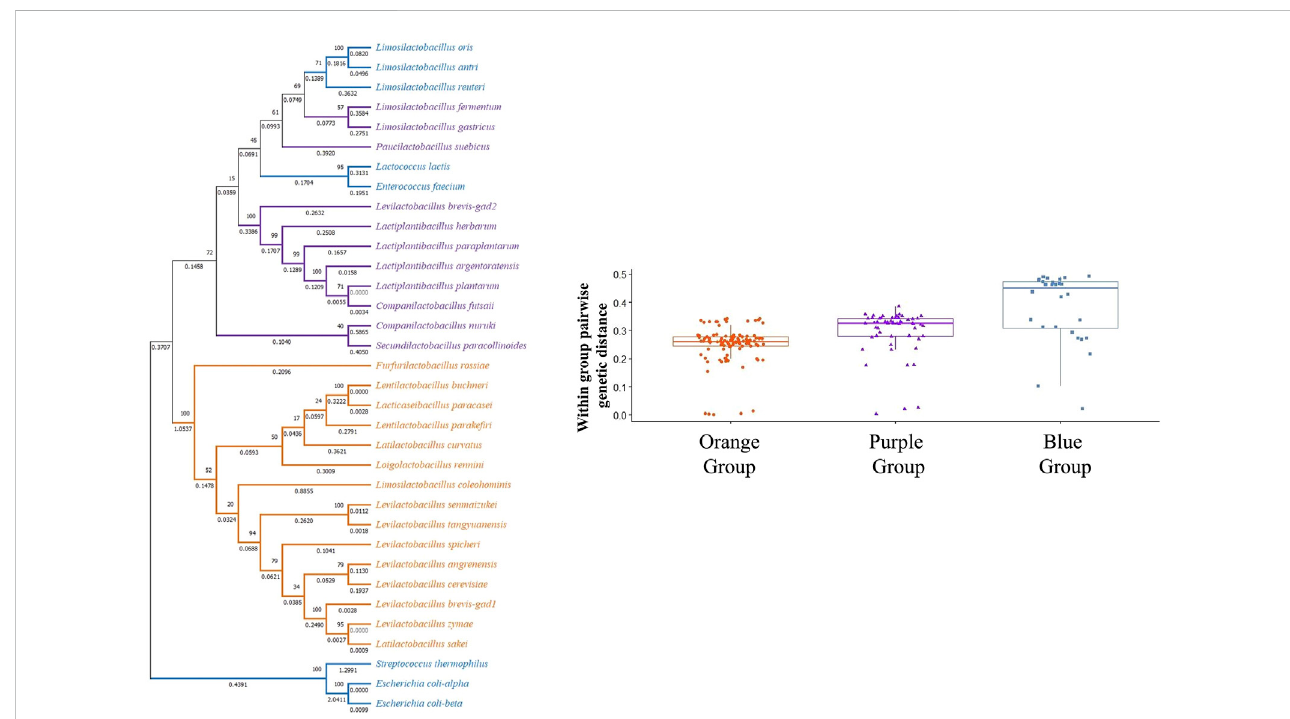
FIGURE 6 Phylogenetic tree based on gad gene sequences from 32 bacterial species. The tree was constructed with MEGA-X using the Maximum Likelihood method and General Time Reversible (GTR) model. One thousand replicates were used to generate the bootstrap consensus tree. A discrete Gamma (G) distribution was used for evolutionary rate variations across sites. Numbers on the nodes show the bootstrap support, numbers on the branches show substitutions per site. Orange color represents species where GADpathwaygenes are organizedinan operon structure. Purple color represents species without an operon structure, and blue color represents species with a small operon structure consisting of only a transporter and a GAD